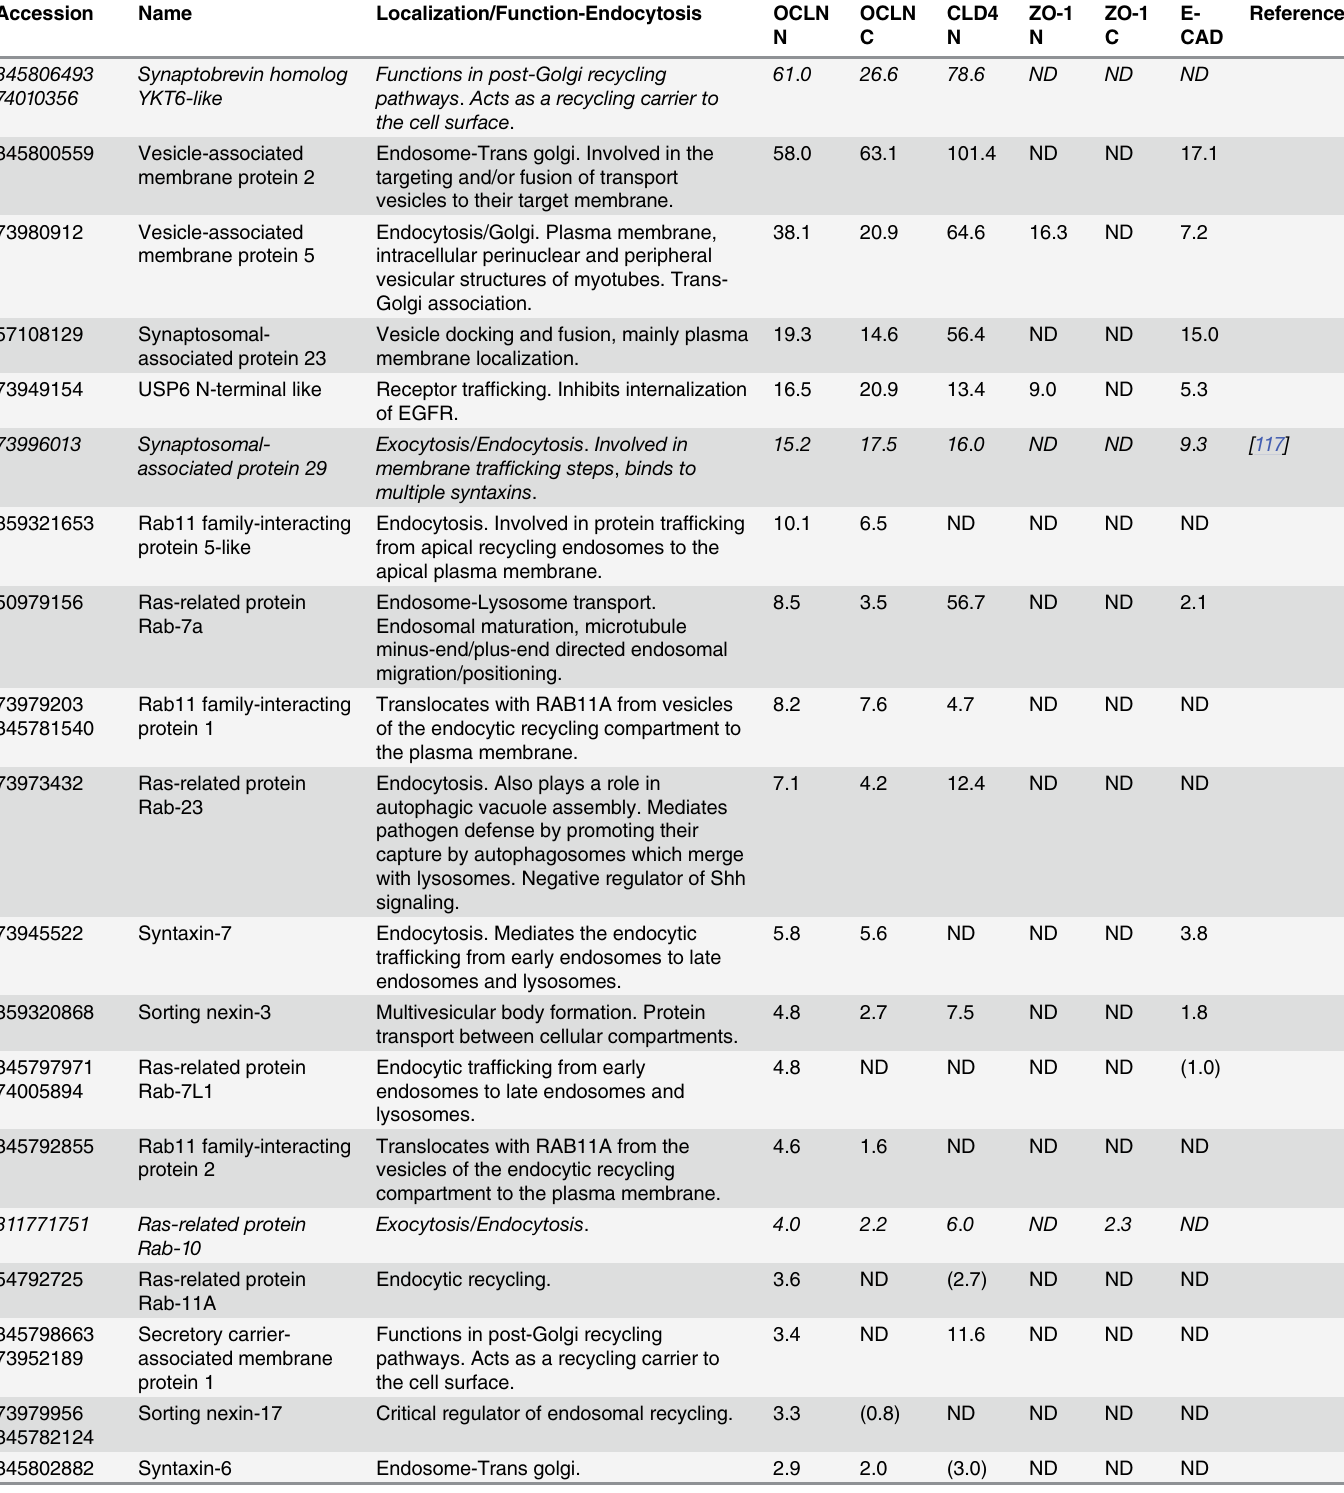
Table 4. Enriched endosomal- and membrane-traf fi cking proteins tagged by biotin ligase fused to occludin and claudin-4.